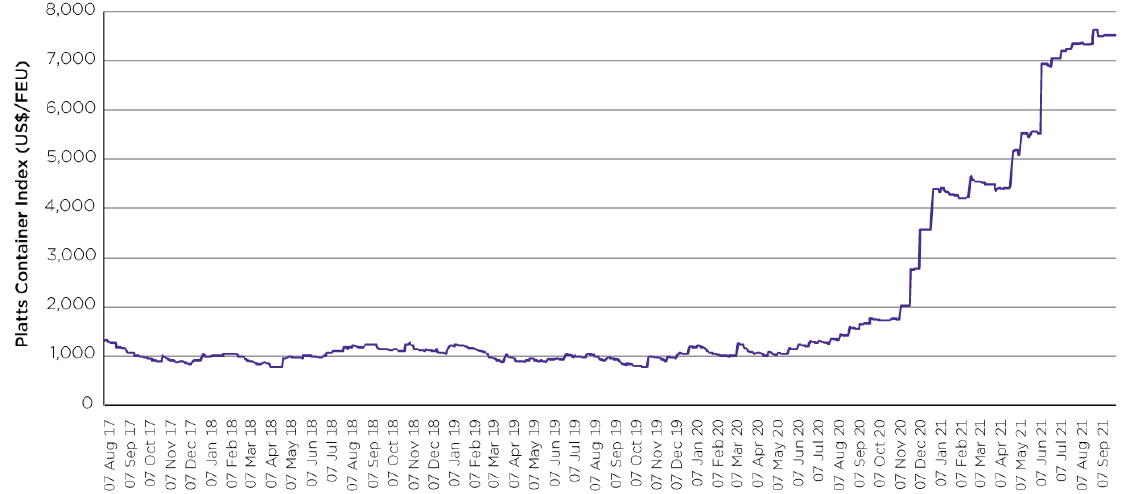
Figure 17. S&P Global Platts container index (US$/FEU): August 2017 to September 2021. Source: Elliott [39].